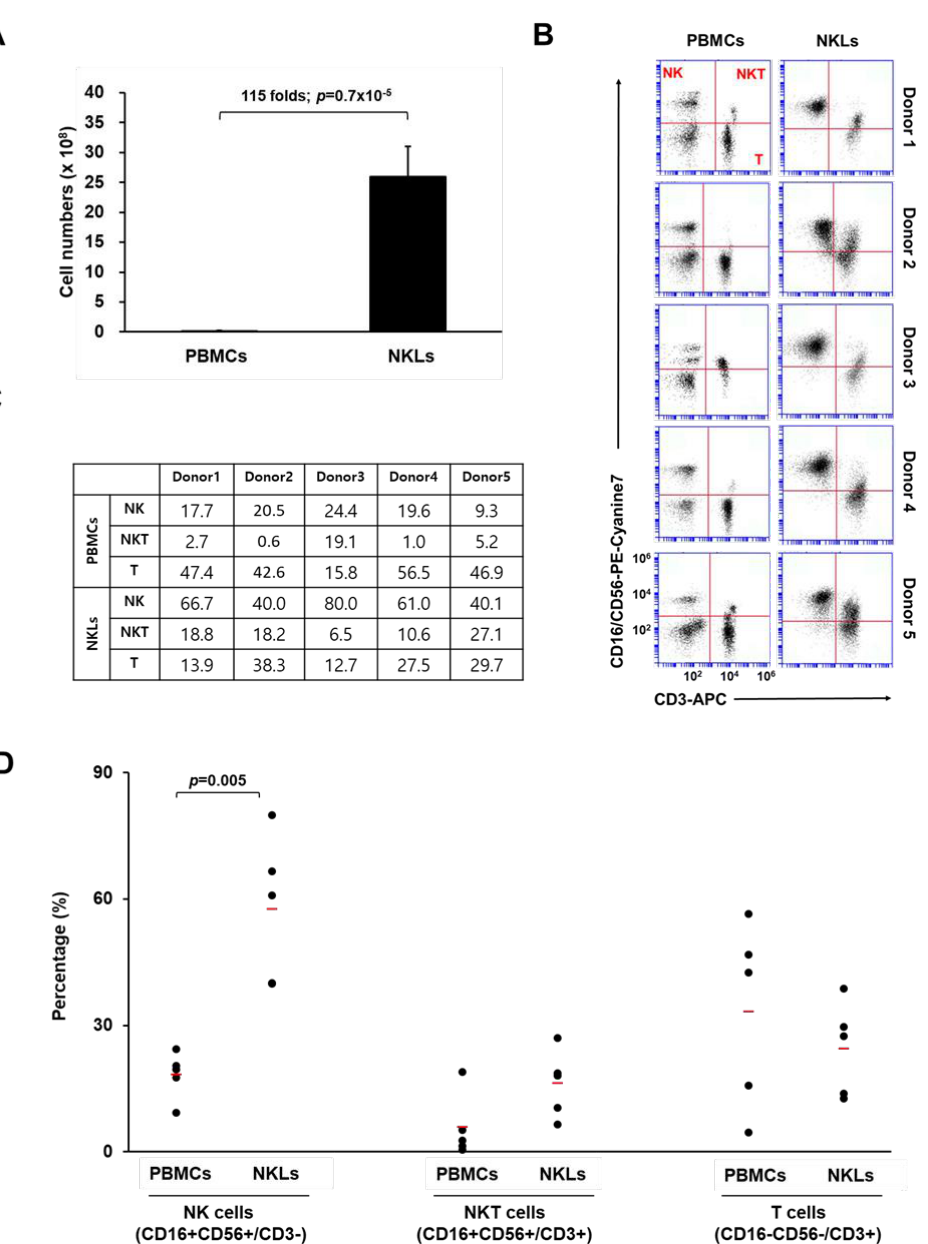
Figure 1. Characterization of expanded natural killer (NK)-cell-enriched lymphocytes (NKLs). ( A ) Comparison of total cell numbers. ( B ) Distribution of NK (CD3 − CD16 + CD56 + ), NKT (CD3 + CD16 + CD56 + ), and T cells (CD3 + CD16 − CD56 − ) compared between peripheral blood mononuclear cells (PBMCs) and NKLs from 5 individuals. ( C ) Percentages of NK, NKT, and T cells